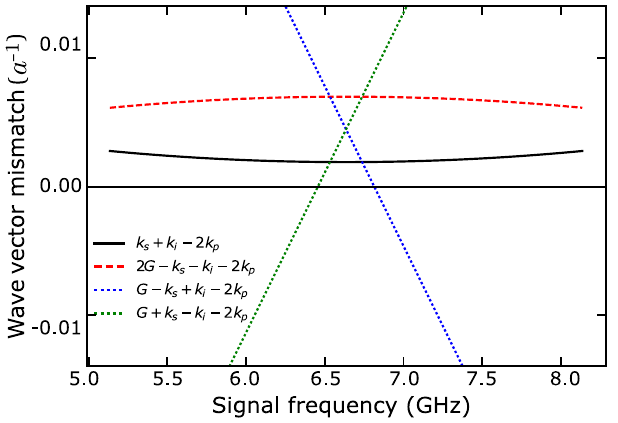
FIG. 10. Wave vector mismatch for four wave combinations — candidates for amplification. The solid line corresponds to the desired amplifier operation. The dashed line corresponds to the potential parasitic amplification of backward propagating signal and idler. The two dotted lines correspond to signal and idler propagating in opposite directions. Pump frequency and power are 6.901 GHz and − 70 dBm,